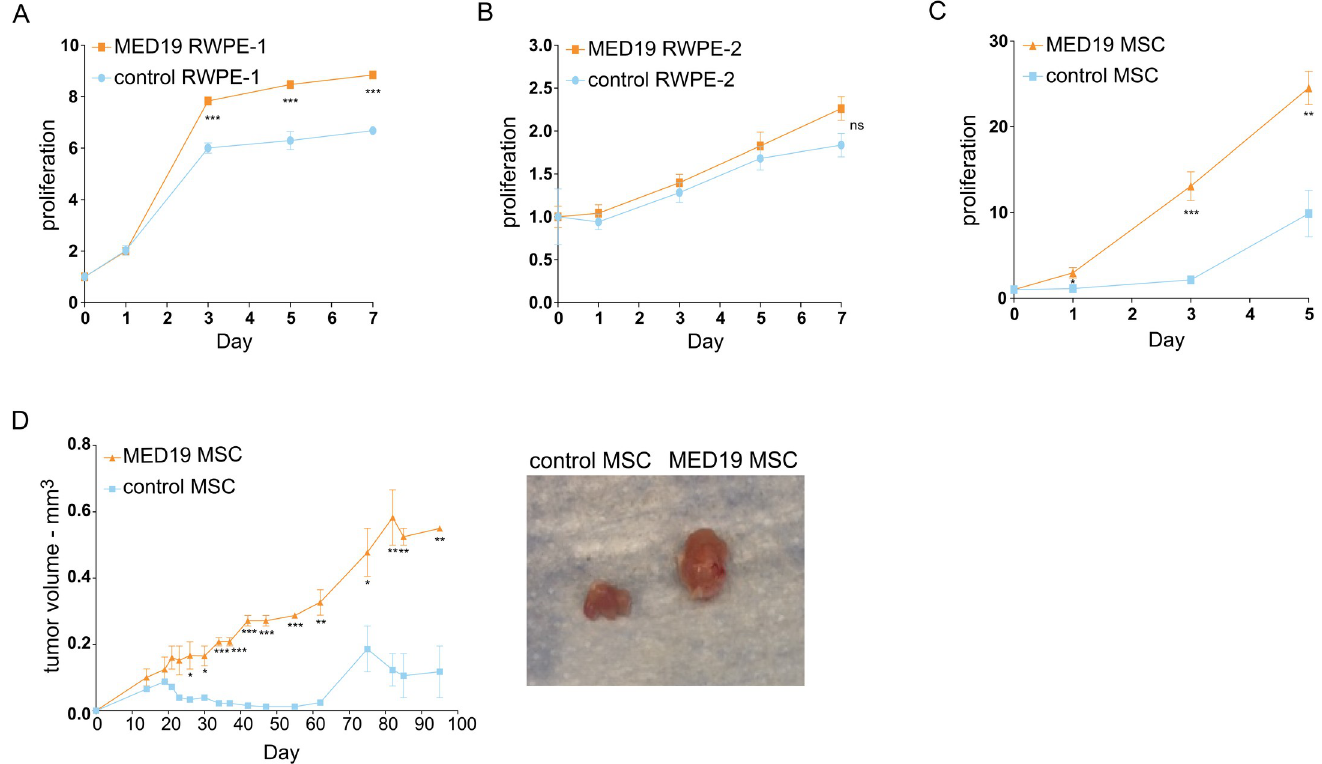
Fig 2. MED19 overexpression promotes proliferation in vitro in non-malignant RWPE-1 cells and in vitro and in vivo in mouse prostate stem cells. A) RWPE- 1, B) RWPE-2, or C) mouse stem cells (MSC) expressing a constitutively active myristoylated AKT, and stably overexpressing MED19 (MED19 RWPE-1/RWPE-2/ MSC) or control empty vector (control RWPE-1/RWPE-2/MSC), were cultured in their standard media. A-C) Proliferation was measured over 5 days for the MSC, which have a rapid doubling time, or 7 days for RWPE-1 cells and RWPE-2 cells, and is expressed as fold change in relative fluorescent units (RFU) normalized to Day 0. Experiments were performed in biological duplicate, with representative results shown. D) MED19 MSC or control MSC were injected into the flanks of Nu/J mice and tumor volume was measured over 95 days (2 mice per group). Representative images of tumors taken at time of sacrifice are shown. � p < 0.05; �� p < 0.01; and ��� p < 0.001. ns = not